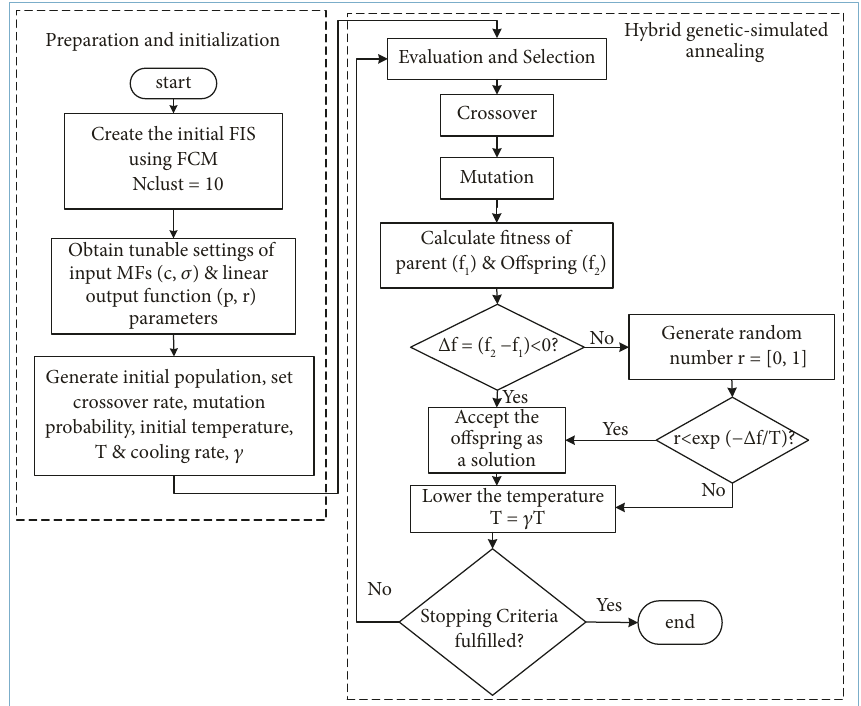
Figure 10: HGSA algorithm applied to tune fuzzy inference system